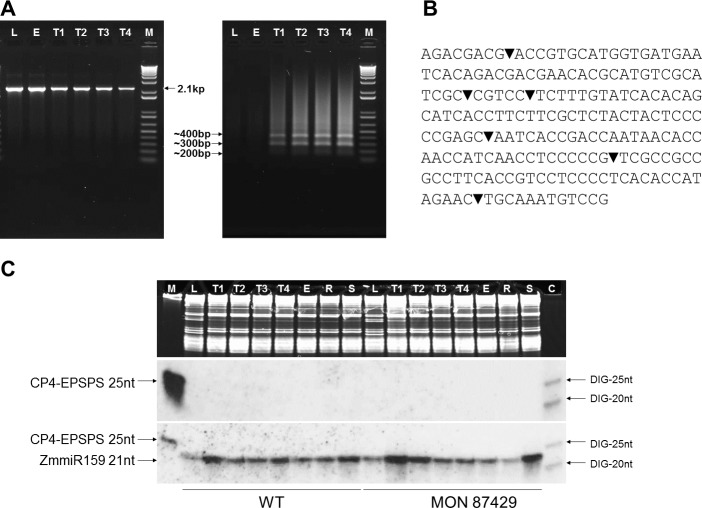
Selective expression of the CP4 EPSPS in plants containing MON 87429.(A) Male tissue-specific cleavage of the CP4 EPSPS transcript. Full length CP4 EPSPS (approximately 2.1 kb) was detected in all tissues while cleaved products (<400 bp) were detected only in tassels from plants containing MON 87429. The extension time was 2 min 10 sec for the uncleaved transcript or 25 sec for cleavage products, respectively. M: 1kb Plus DNA size marker (Thermo Fisher Scientific); L: V6 leaf; E: VT ear; T1: V6 tassel; T2: V8 tassel; T3: V10 tassel; T4: V12 tassel. (B) Sequence-specific cleavage of the CP4 EPSPS. Cleavage sites (▼) were identified on the mts-siRNA target sequence (201 bp) in the CP4 EPSPS transcript by sequencing the 5’RACE products. (C) Absence of CP4 EPSPS small RNAs. Total RNA (10 μg) from various tissues of WT (left) or plants containing MON 87429 (right), respectively, was used for RNA blotting. The upper shows equal loading and quality of the RNA samples by sharp, distinct ribosomal RNA bands in TBE-urea denaturing polyacrylamide gel (ethidium bromide stained). M: a mix of the 1kb RNA ladder (1 μg) and a synthetic 25-nt CP4 EPSPS RNA oligo (1 ng) as a positive control; T1: V6 tassel; T2: V8 tassel; T3: V10 tassel; T4: V12 tassel; E: VT ear; L: V6 leaf; R: VE root; S: VE shoot; C: synthetic DIG-labeled 20- and 25-nt RNAs as small size markers. The middle represents the low molecular weight RNA blot that was hybridized with three DIG-labeled probes covering the whole CP4 EPSPS transcript except the 201-bp target region. The lower illustrates the small RNA blot that was reprobed for miR159 after stripping off the CP4 EPSPS probes to demonstrate small RNA quality of in the samples. VE: emergence stage; Vn: leaf stages by number of leaves on the maize plant; VT: tasseling stage.